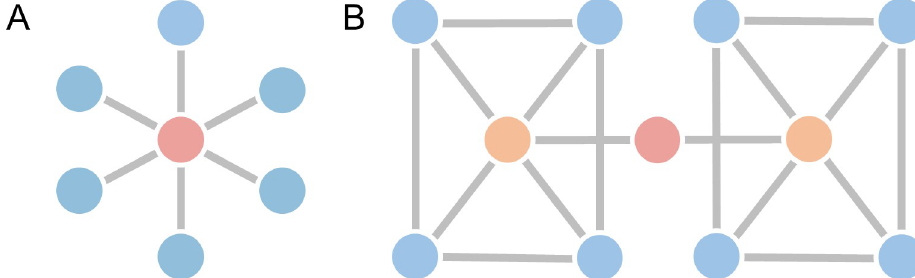
Fig 1. Basic properties of topological centrality. Panel A shows an example of a star network. The red node has maximal degree (greatest number of connections), closeness (is a short distance from other nodes) and betweenness (lies on many shortest-paths between nodes) in this network. In this case these three centrality measures are perfectly concordant. Panel B shows a network in which centrality measures are not concordant. The red node has the highest betweenness and closeness, but it has the lowest degree in the